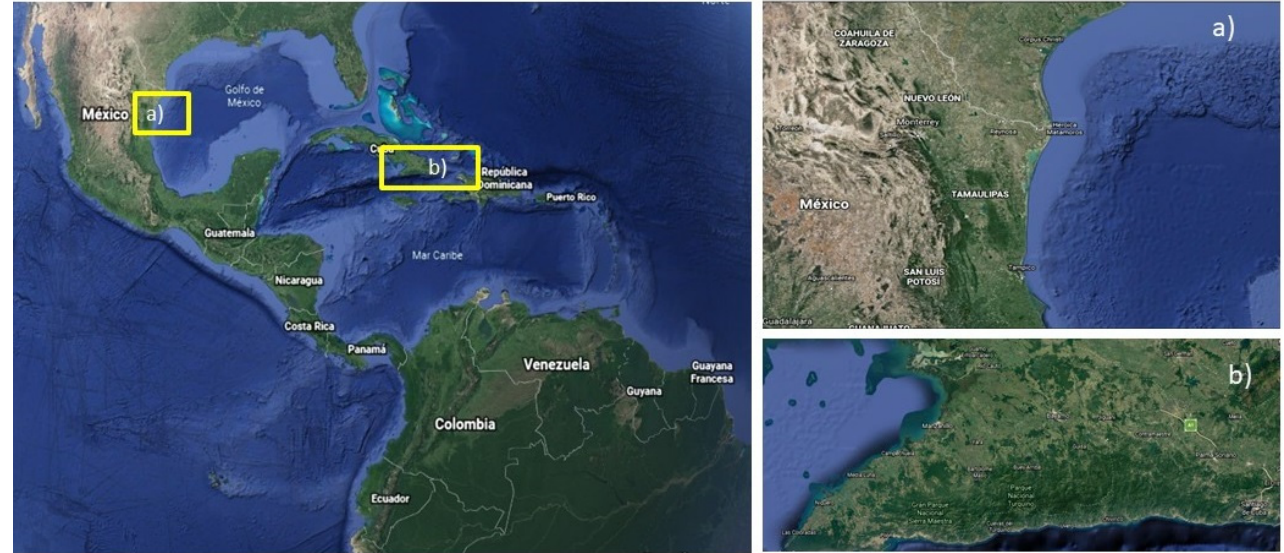
Figure 4. Study area for the application of CMI. Caption: ( a ) Tamaulipas State, Mexico. ( b ) Guama Municipality, Province of Santiago de Cuba, Cuba.